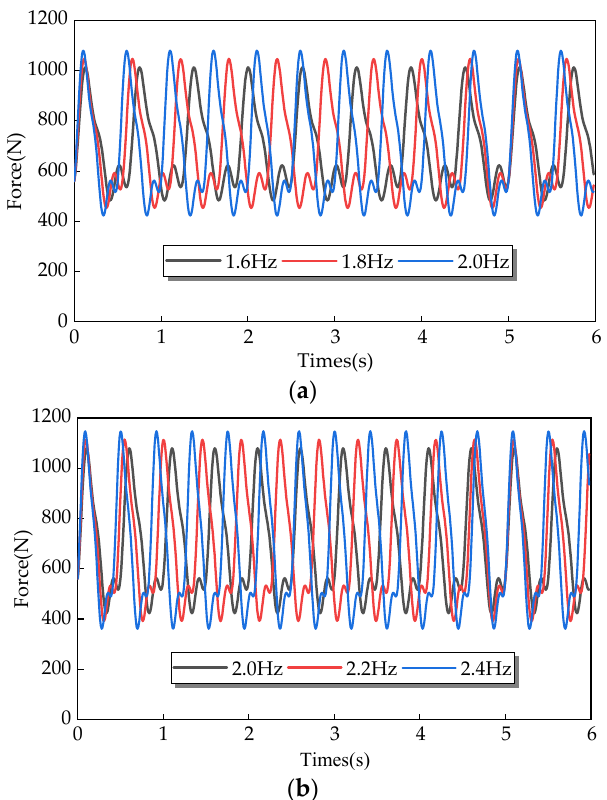
Figure 10. Pedestrian loads with different frequencies: ( a ) walking frequencies of 1.6 Hz, 1.8 Hz, and 2.0 Hz; ( b ) walking frequencies of 2.0 Hz, 2.2 Hz, and 2.4 Hz.